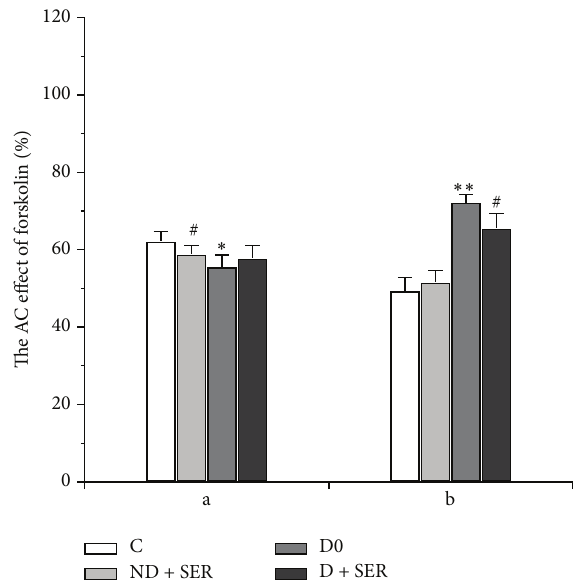
Figure 8: The AC inhibiting effects of norepinephrine and somato- statin in the myocardium of diabetic and nondiabetic rats with and without IS treatment. a—norepinephrine (10 −5 M) and b— somatostatin-14 (10 −6 V ). The AC stimulating effect of forskolin (10 −5 M) in the absence of hormone is taken as 100%. The data are presented as M ± SD. ( ∗ , ∗∗ ) The difference between Groups C and D0 is significant at 𝑃 < 0 . 05 and 𝑃 < 0 . 0001, respectively, and (#) the difference between Groups C and ND + SER or between Groups D0 and D + SER is significant at 𝑃 < 0 .